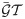
Execution time to solve Problem 1.(a),(b) The computational expense with waiting included is bimodal with the dominant mode at higher computation times. Bimodality indicates calculation of waiting paths falls into two populations: optimal waiting paths found in a narrow search of G¯T, and optimal waiting paths found in a broader search of G¯T. This observation identifies two characteristically different threat field families. (c),(d) Computational expense (execution time) when waiting is not allowed.